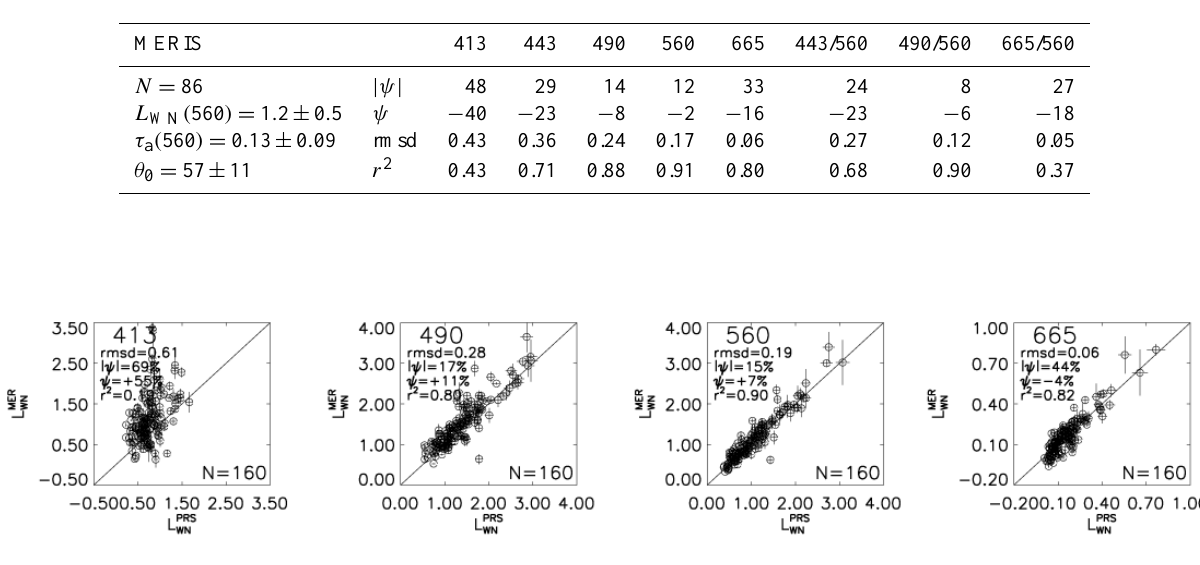
Fig. 1. Scatter plot of MERIS (MER) versus AERONET-OC (PRS) L WN match-ups at selected center wavelengths determined at the AAOT with 1t =± 1h. MER L WN were generated from the 2nd Reprocessing. N indicates the number of match-ups, L WN and rmsd are in units of mW cm − 2 µm − 1 sr − 1 , | ψ | is the mean of absolute percent differences while ψ is the mean of percent differences, and r 2 is the determination coefficient.